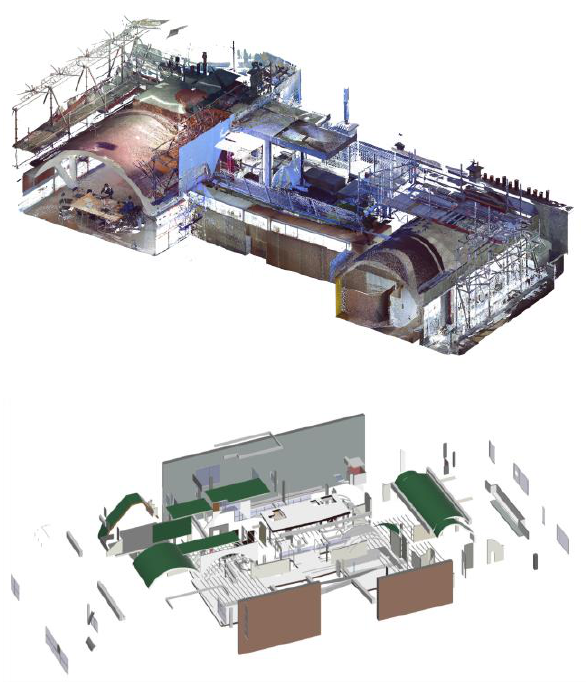
Figure 8. 3D model of the apartment